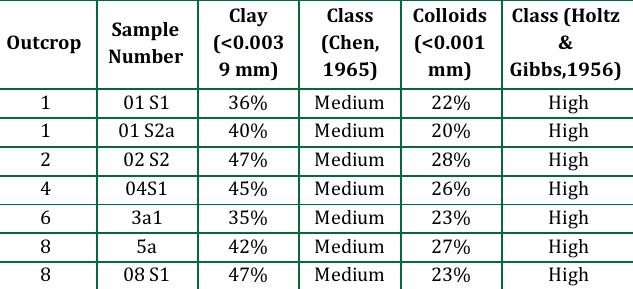
Table 3: Swell potential classification of mudstones based